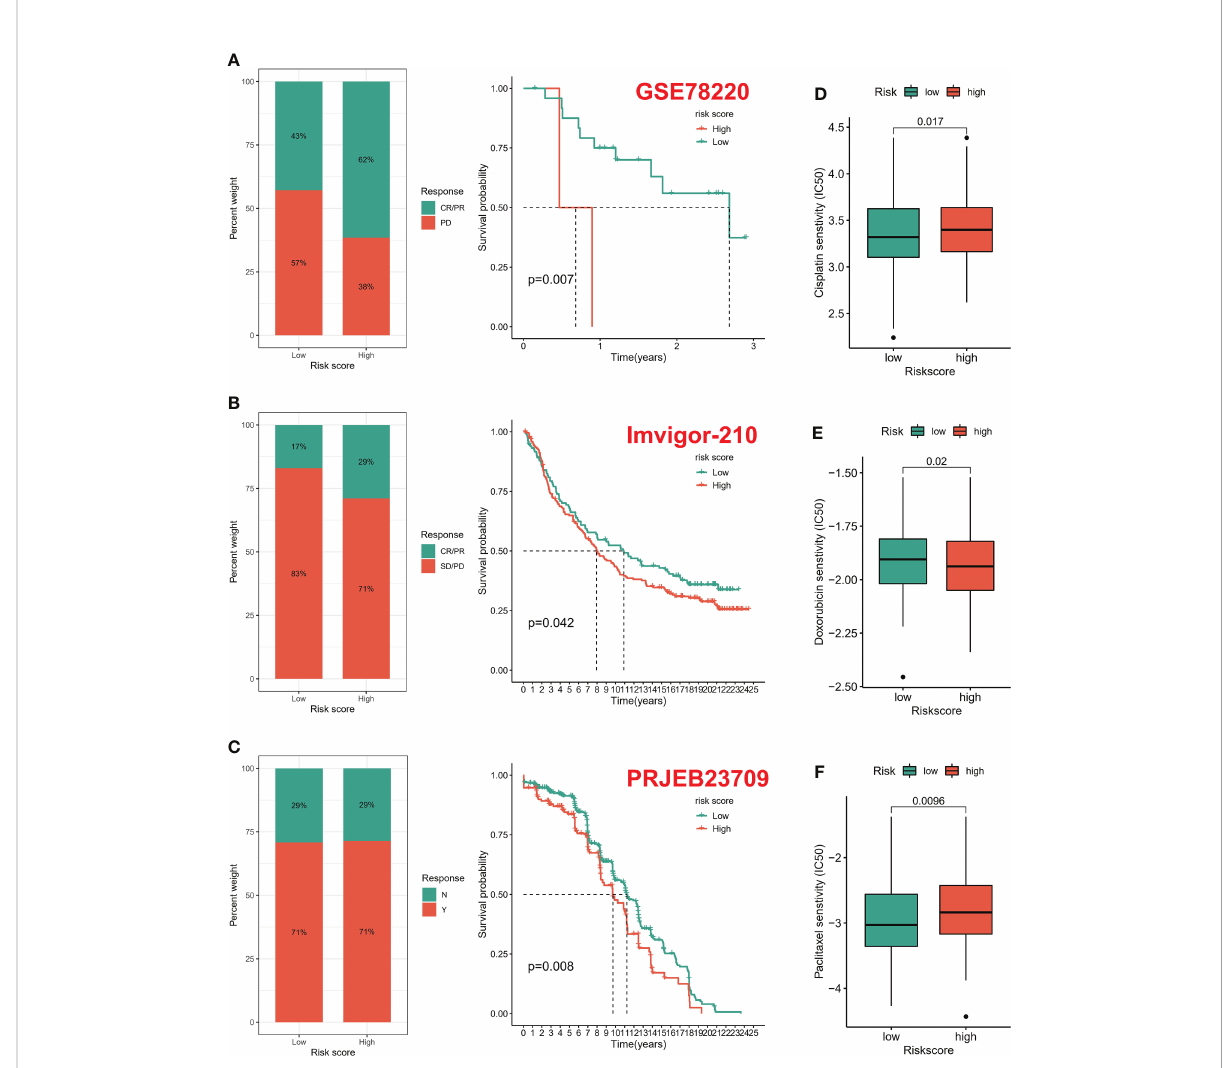
FIGURE 7 Drug susceptibility prediction. (A – C) Treatment effect prediction in three immunotherapy cohorts (GSE78220, IMVigor-210, PREB23709). (D – F) Chemotherapeutic drug sensitivity